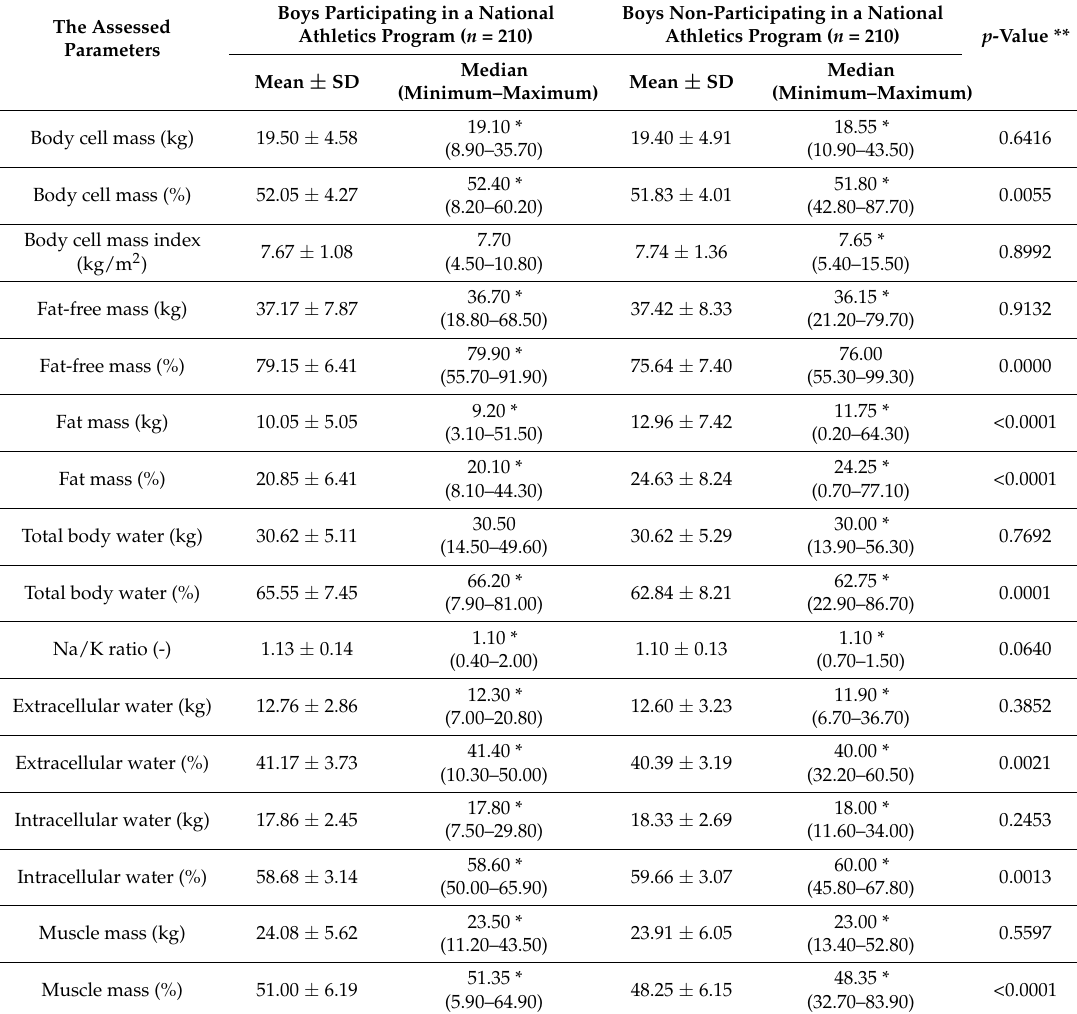
Table 6. The body composition in group of boys participating in a national athletics program and pair-matched control group of